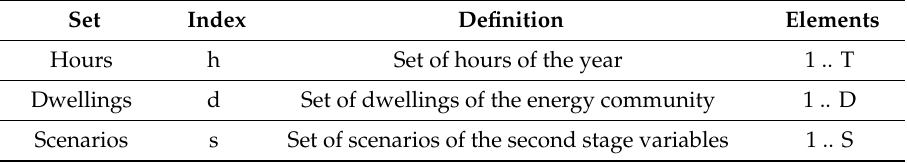
Table 1. Sets of the mathematical